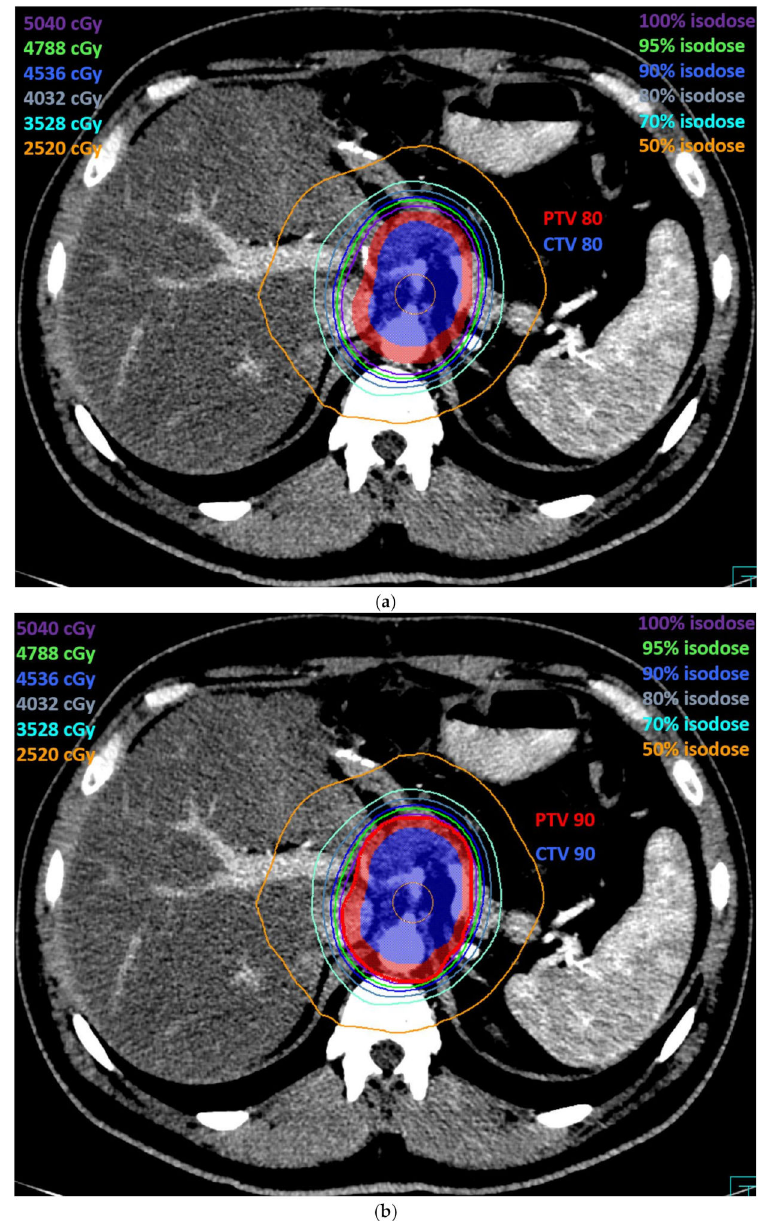
Figure 6. The axial view of a VMAT plan dosimetry covering the new proposed region of interest with regard to CTV80, PTV80 ( a ), CTV90, and PTV 90 ( b